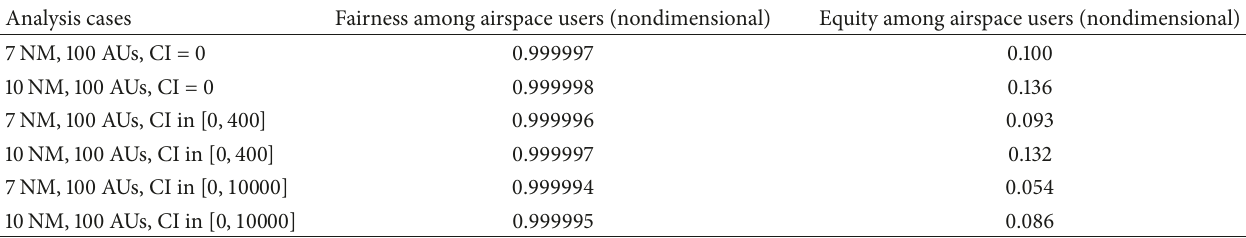
Table 6: Variation in fairness and equity among airspace users with different versions of the algorithm and different CI allocations. Analysis